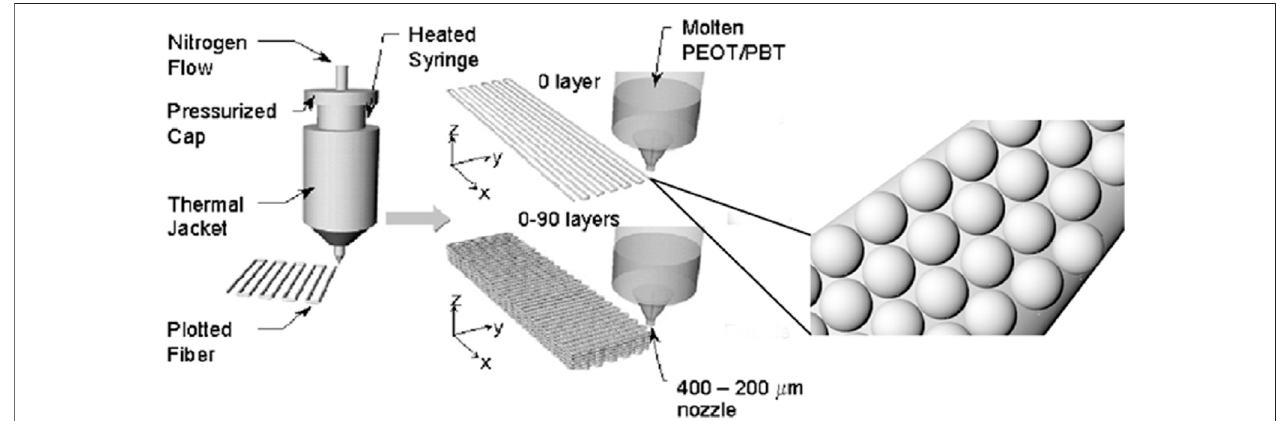
FIGURE1| Schematicshowingthe3D fi berdepositionprocess.AcolloidalsolutionofmicrospheresembeddedintoasecondpolymericcarrierXisextrudedintoa computer-aided design pattern through a nozzle of 200 – 400 µm internal diameter by applying a nitrogen pressure. The syringe containing the colloidal solution can be heated or maintained at room temperature. Adapted from Wood fi eld et al.